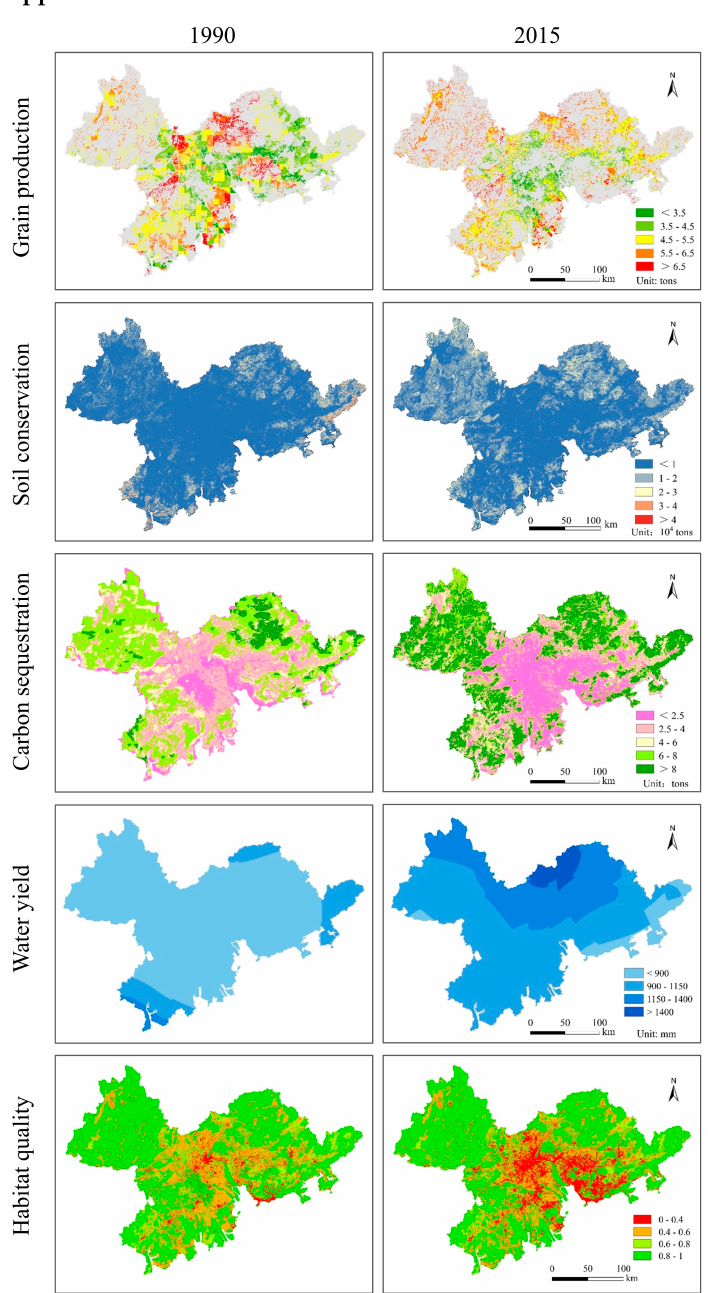
Figure A1. Spatial distribution of the ecosystem services supply in 1990 and 2015 in the Pearl River Delta, (Source: Liu et al., 2022